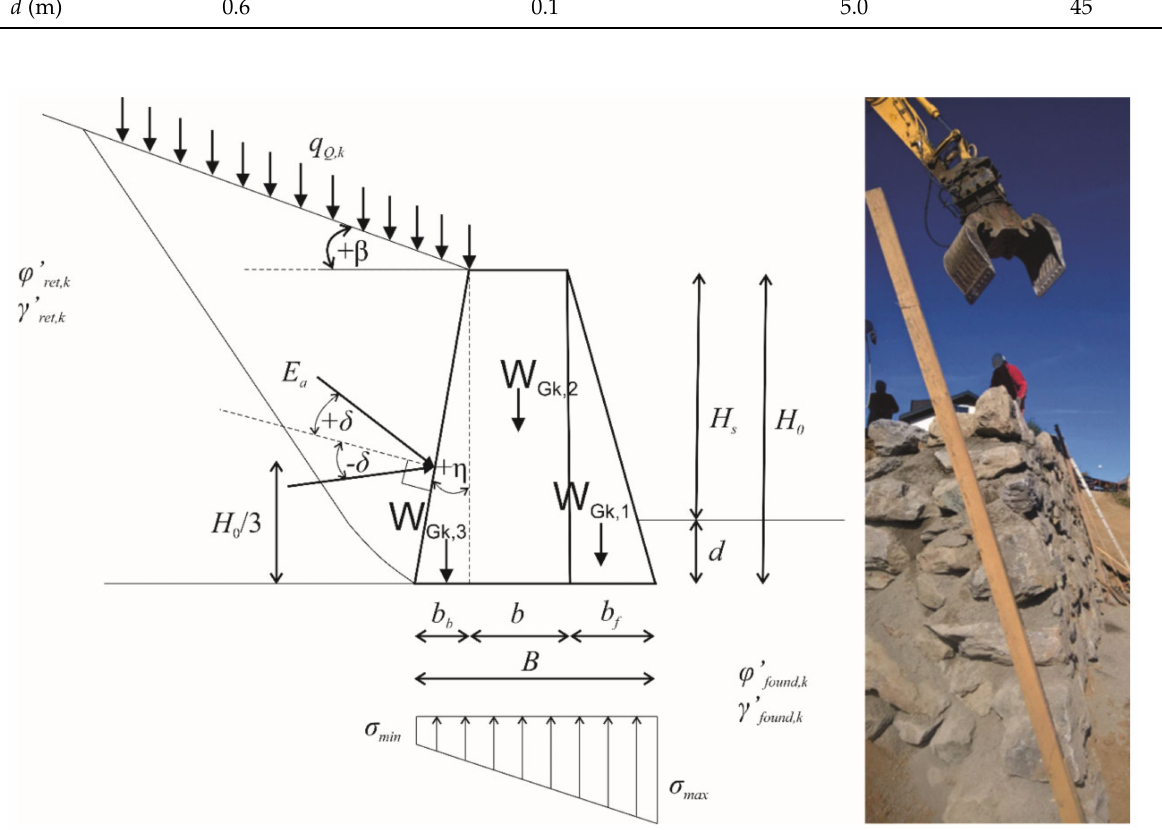
Figure 1. Geometry and parameters of a gravity retaining